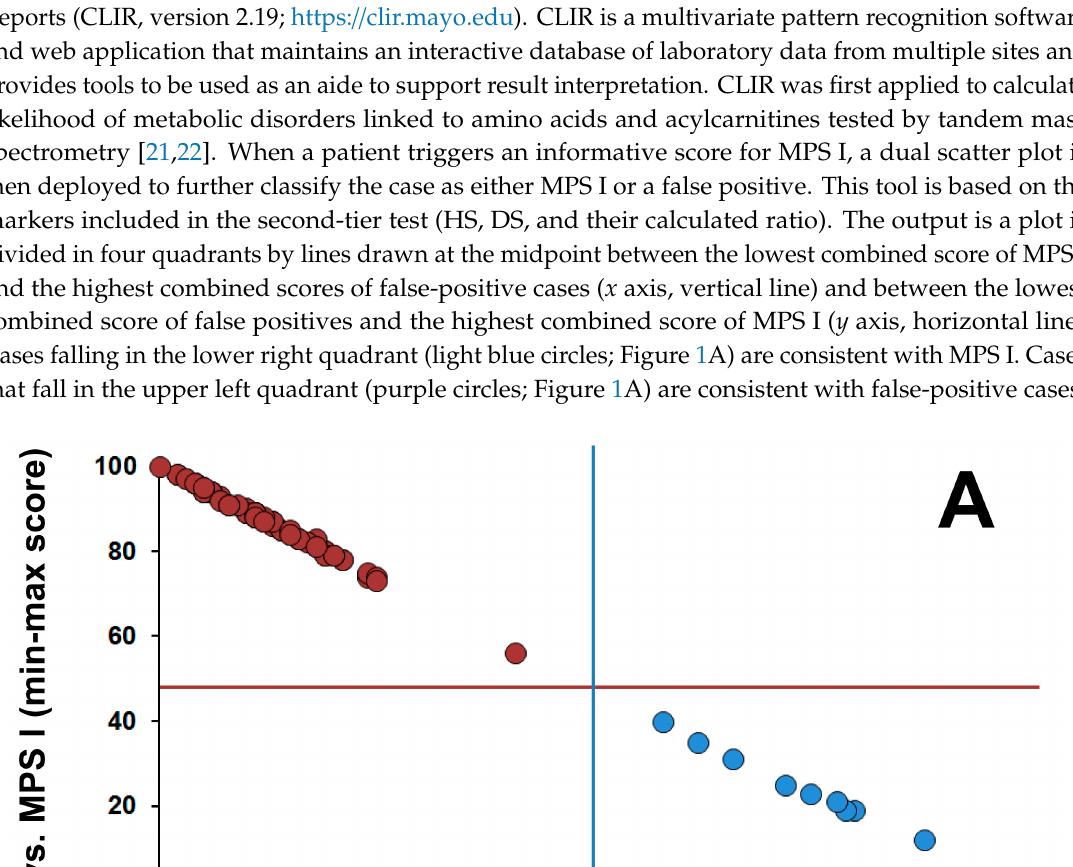
Figure 1. CLIR dual scatter plot; calculated to help determine the differential diagnosis between low IDUA activity more likely being true positive due to MPS I vs. false positive due to pseudo deficiency or IDUA carrier status. ( A ) Distribution of scores of cases (MPS I (blue dots) n = 10; false positives (purple circles) n = 67) confirmed by genotyping; ( B ) Distribution of scores of 7 cases with two variants in trans and at least one variant of uncertain significance (VUS; either pathogenic/VUS and VUS/VUS) and one case with no genotype. 3. Results Out of 1213 specimens, 1067 were found to have had normal concentrations of both DS and HS (group 1), 76 had either DS or HS above the reference value for age (group 2) and 23 were found to have concentrations of both DS and HS above the reference values for age (group 3). Characteristics of IDUA variants for all resolved cases are available in Table S1.